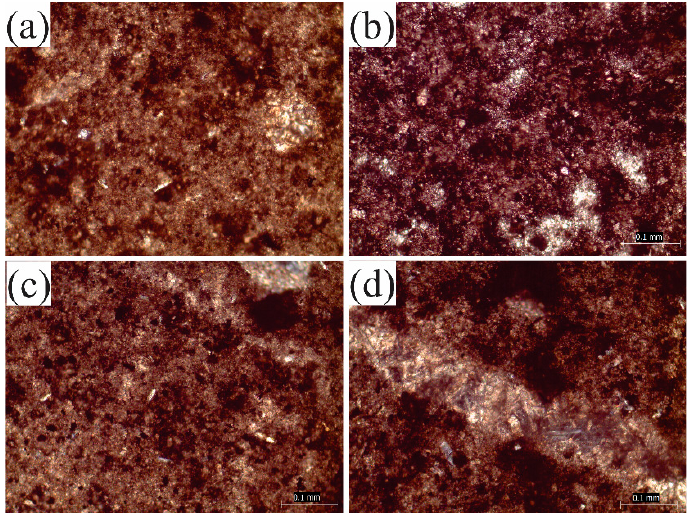
Figure 10. Photomicrographs showing ( a ) dolomitized bioclast and gypsum; ( b ) gypsum, hematite and micrite; ( c ) gypsum and pyrite; and ( d ) chert.